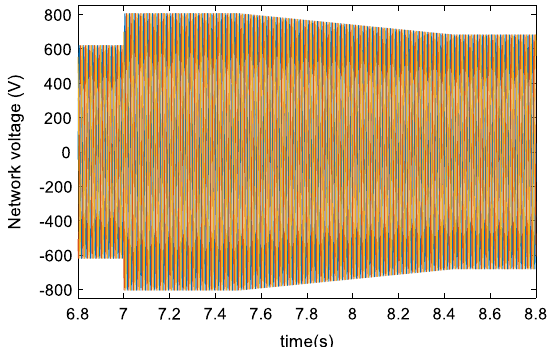
Fig. 23 Rotor voltage of the DFIG during symmetrical voltage sag